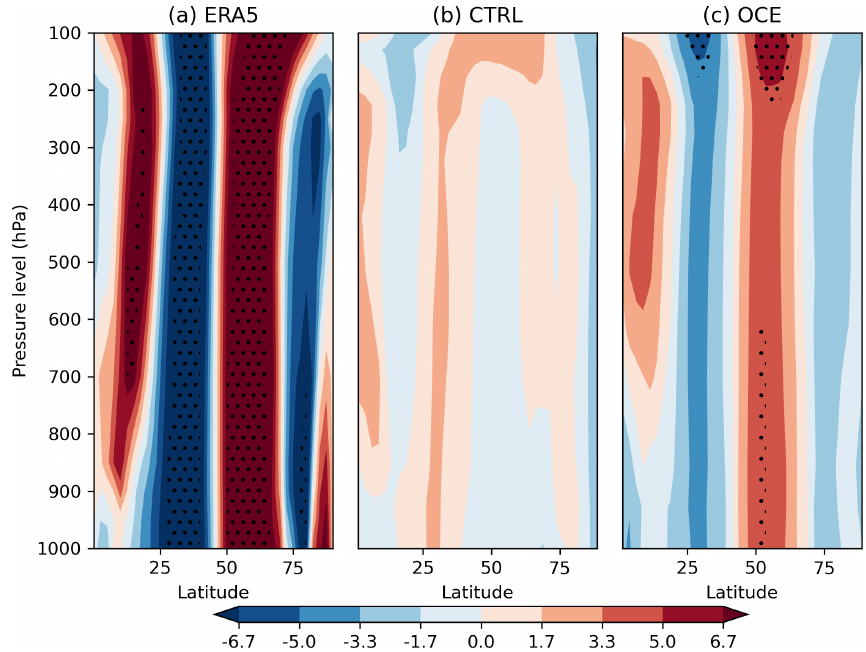
Figure 5. Regression coefficients of November BKS sea ice against zonally averaged DJF zonal winds at various latitudes (degrees north) and pressure levels (hPa) in (a) ERA5, (b) CTRL, and (c) OCE. The period considered is 1980–2015. Stippling highlights grid points where the associated correlation coefficient is statistically significant ( p < 0 .